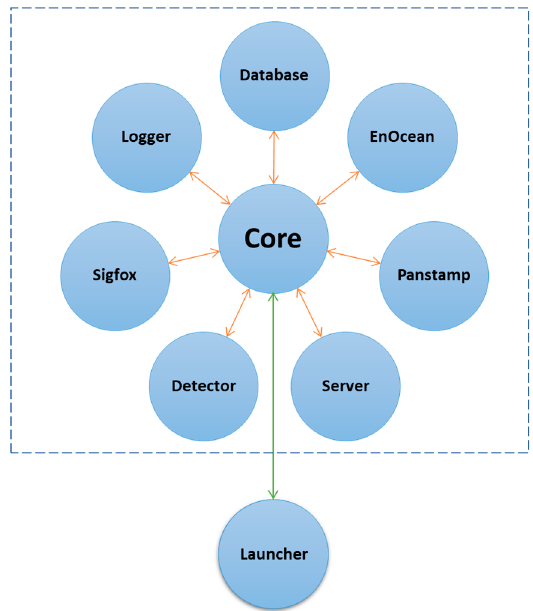
Figure 10. Software modules.